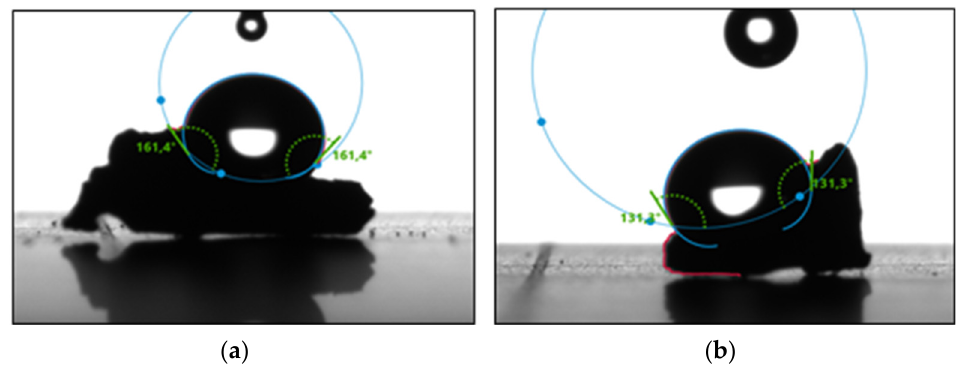
Figure 20. Contact angle: ( a ) unmodified rubber 161.4°, ( b ) rubber under treatment R1, 131.3°.